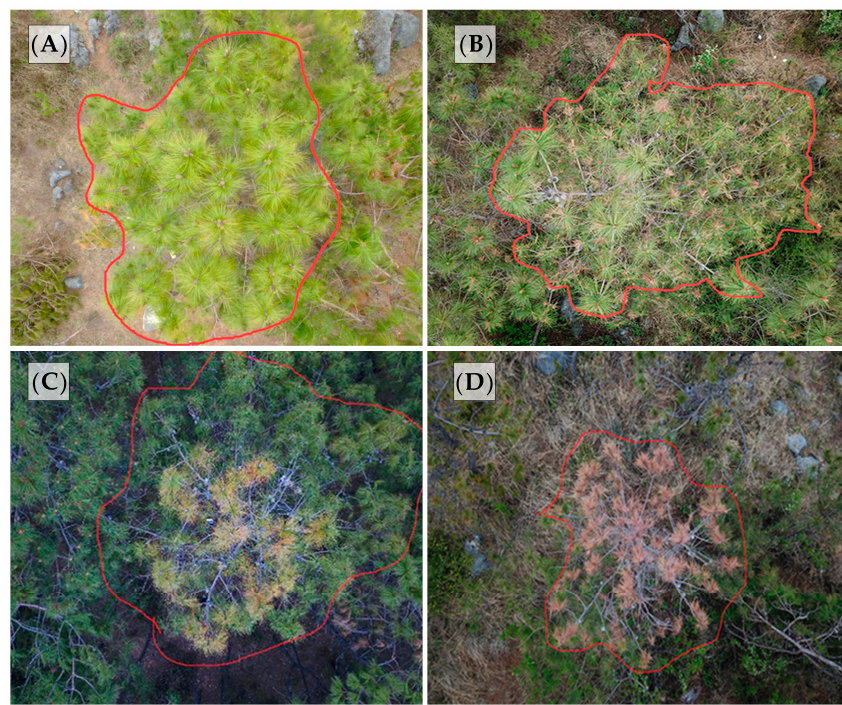
Figure 4. The canopy range of different damage degrees. ( A ) Healthy. ( B ) Mild damage. ( C ) Moderate damage. ( D ) Severe damage.